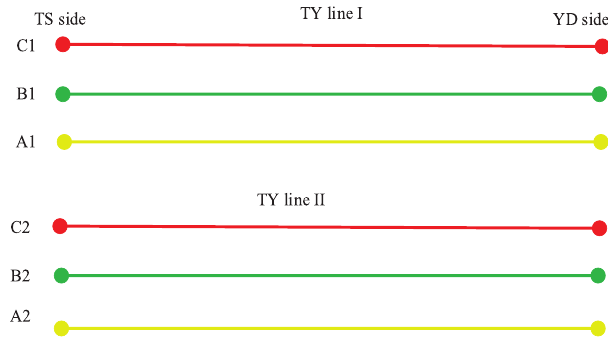
Fig. 1. Phase sequence arrangement of double